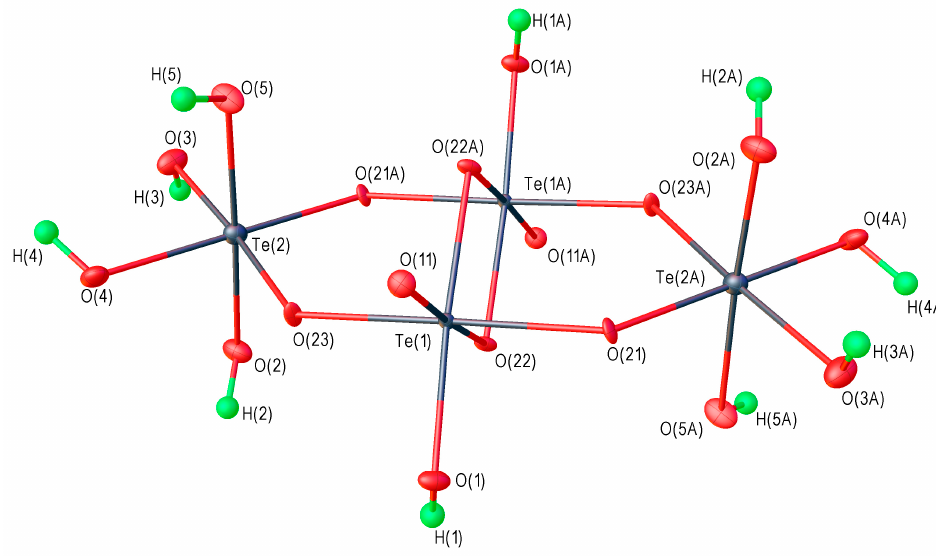
Molecules 2022 , 27 , x FOR PEER REVIEW Figure 7. Structure of the [Te 4 O 8 ( О H) 10 ] 2 − anion in compound I . Figure 7. Structure of the [Te 4 O 8 (OH) 10 ]